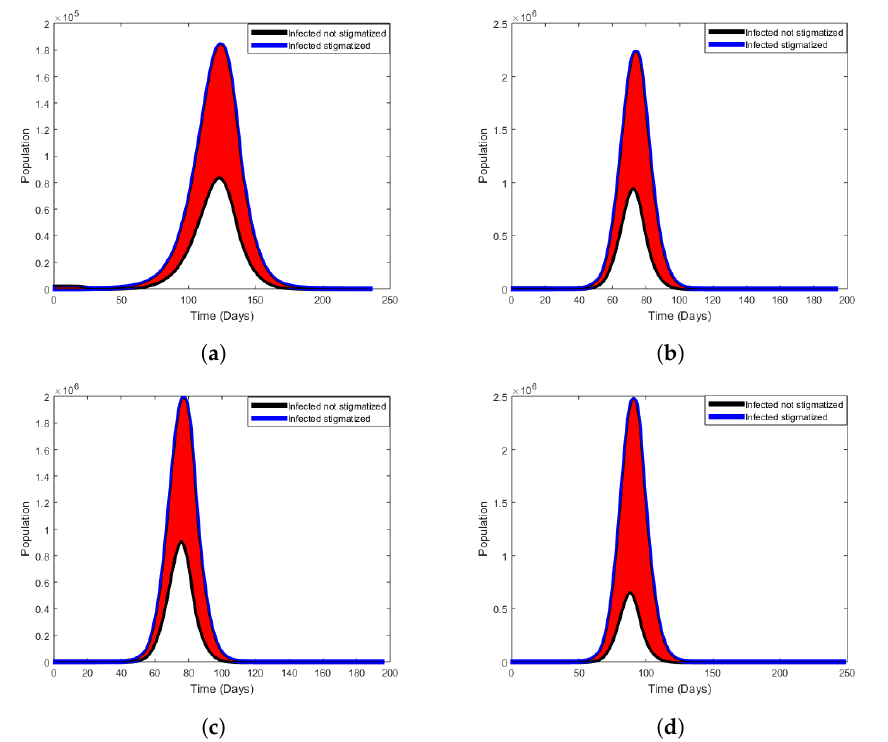
Figure 11. Moderate regime state. ( a ) Wave 1. ( b ) Wave 2. ( c ) Wave 3. ( d ) Wave 4.